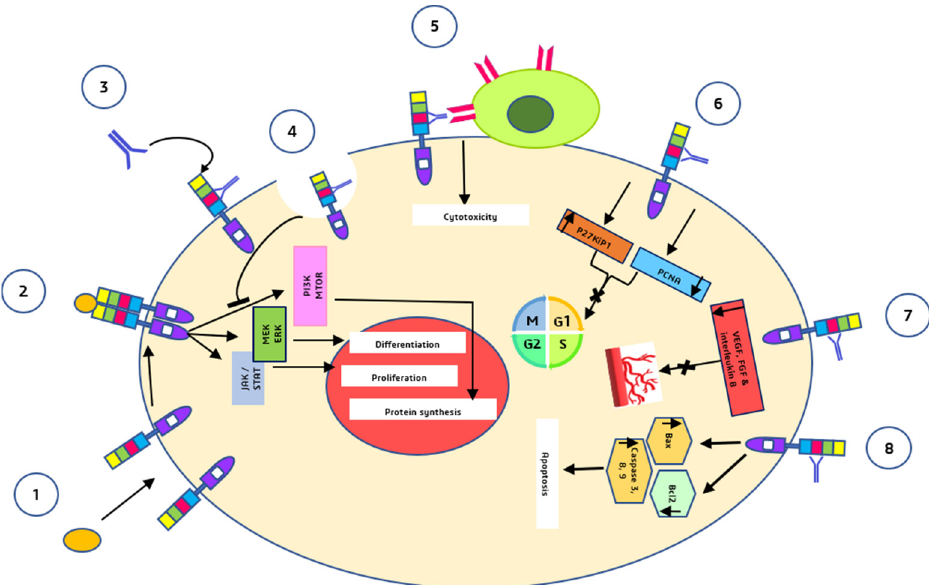
Figure 3. Major anti-tumor mechanisms by which cetuximab acts 1) and 2) are the mechanisms that normally take place in the absence of cetuximab i.e., binding of the ligands to the EGFR monomers, induction of receptor dimerization, and downstream signalling pathways. 3) Cetuximab binds to domain III of EGFR. 4) Receptor internalization mediated by cetuximab and inhibition of downstream signalling pathways. 5) Fc segment of cetuximab binds to natural killer cells and induces ADCC. 6) G1 cell cycle arrest. 7) inhibition of angiogenesis. 8) Induction of apoptosis.